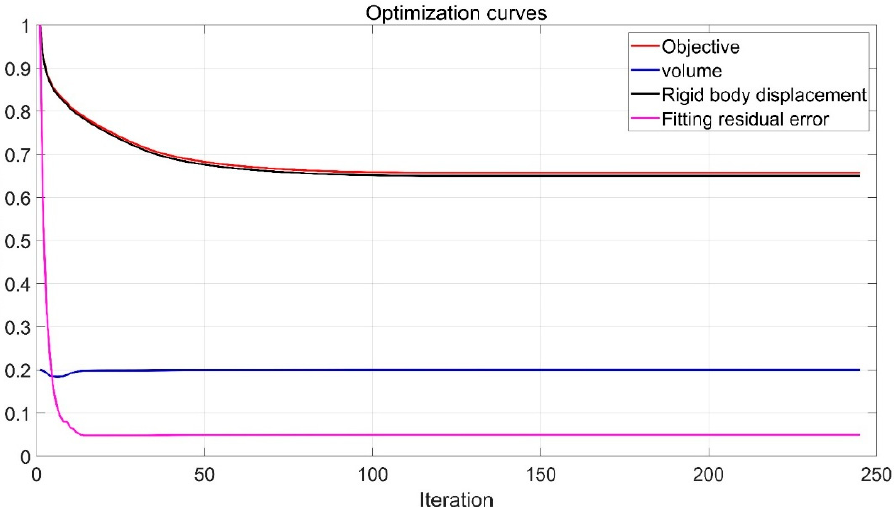
Figure 11. Iterative curves of the normalized objective and constraints in the horizontal condition of the optical axis.